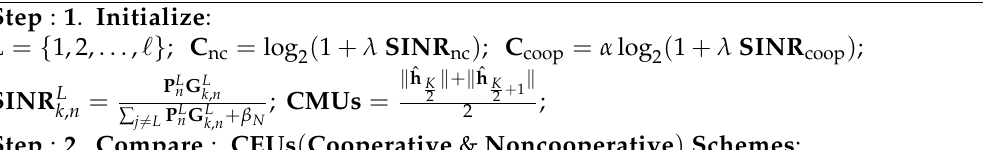
Algorithm 2 K -user and L -cell Cell-Edge Users (CEUs) Partial Cooperation.